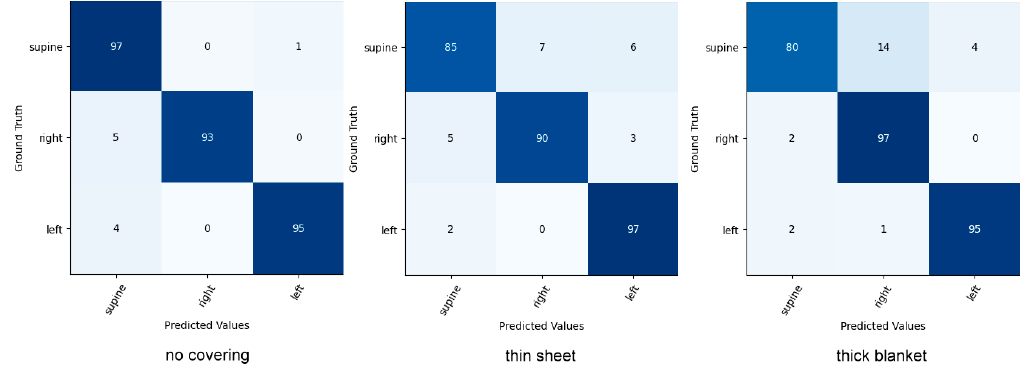
Figure 9. Confusion matrix for upper-body pose classification on the SLP dataset.